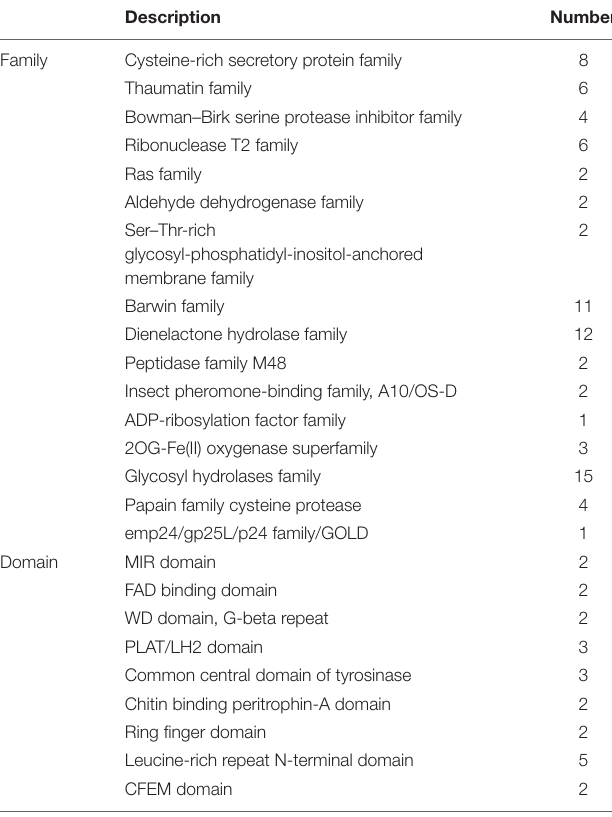
TABLE 1 | Types and quantities of conserved domains of the 635 candidate secreted effector proteins